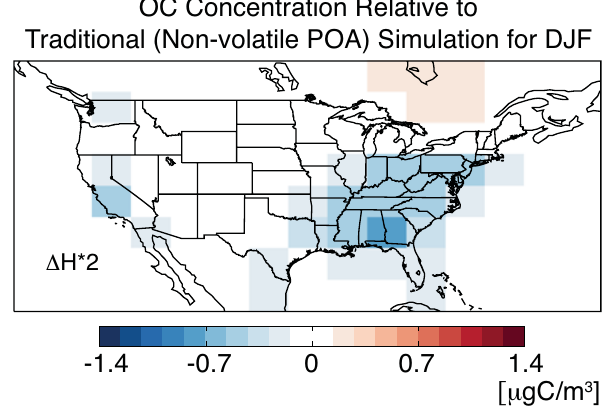
Fig. 9. DJF surface total OC concentration (POA, SOA from SVOCs, SOA from IVOCs, and traditional SOA) from a revised simulation in which the enthalpy of vaporization is 83kJ/mol rela- tive to a non-volatile (traditional) POA simulation (POA and tradi- tional SOA) using GISS meteorology at 4 ◦ × 5 ◦